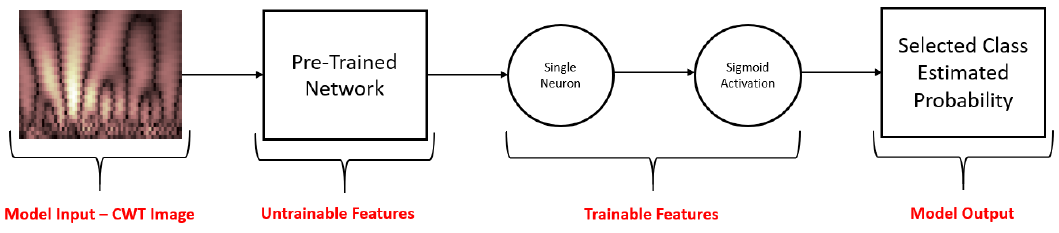
Figure 7. Transfer learning scheme for binary classifier.